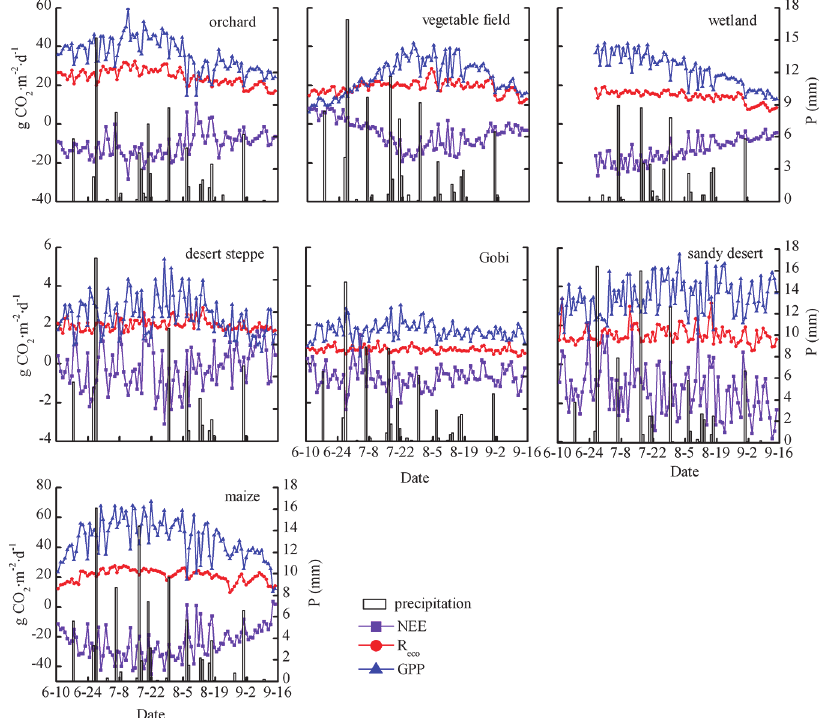
Fig 3. Daily variations in NEE , R eco and GPP in different